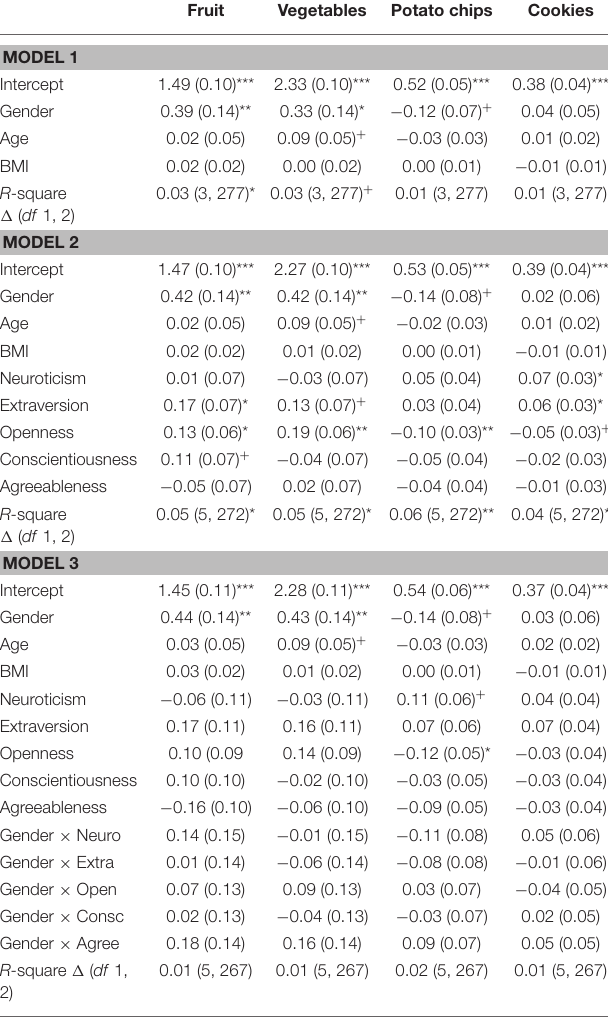
TABLE 2 | Results of hierarchical regression analyses predicting young adults’ fruit and vegetable consumption and unhealthy foods in Sample 1 ( N =